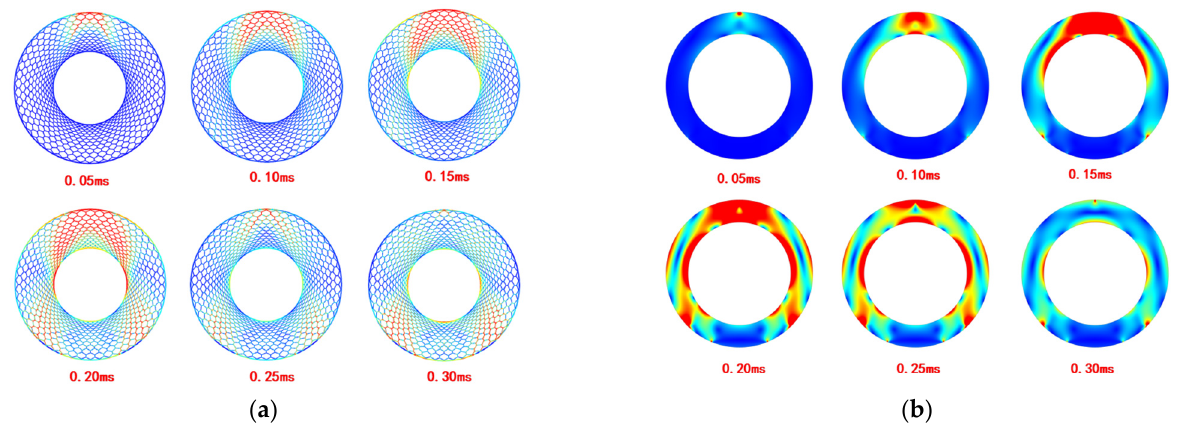
Figure 8. Stress field distributions of the pentamode lattice-ring structure and the solid ring with equal mass. ( a ) Stress field distribution of the pentamode lattice-ring structure; ( b ) stress field distribution of the solid ring with equal mass.